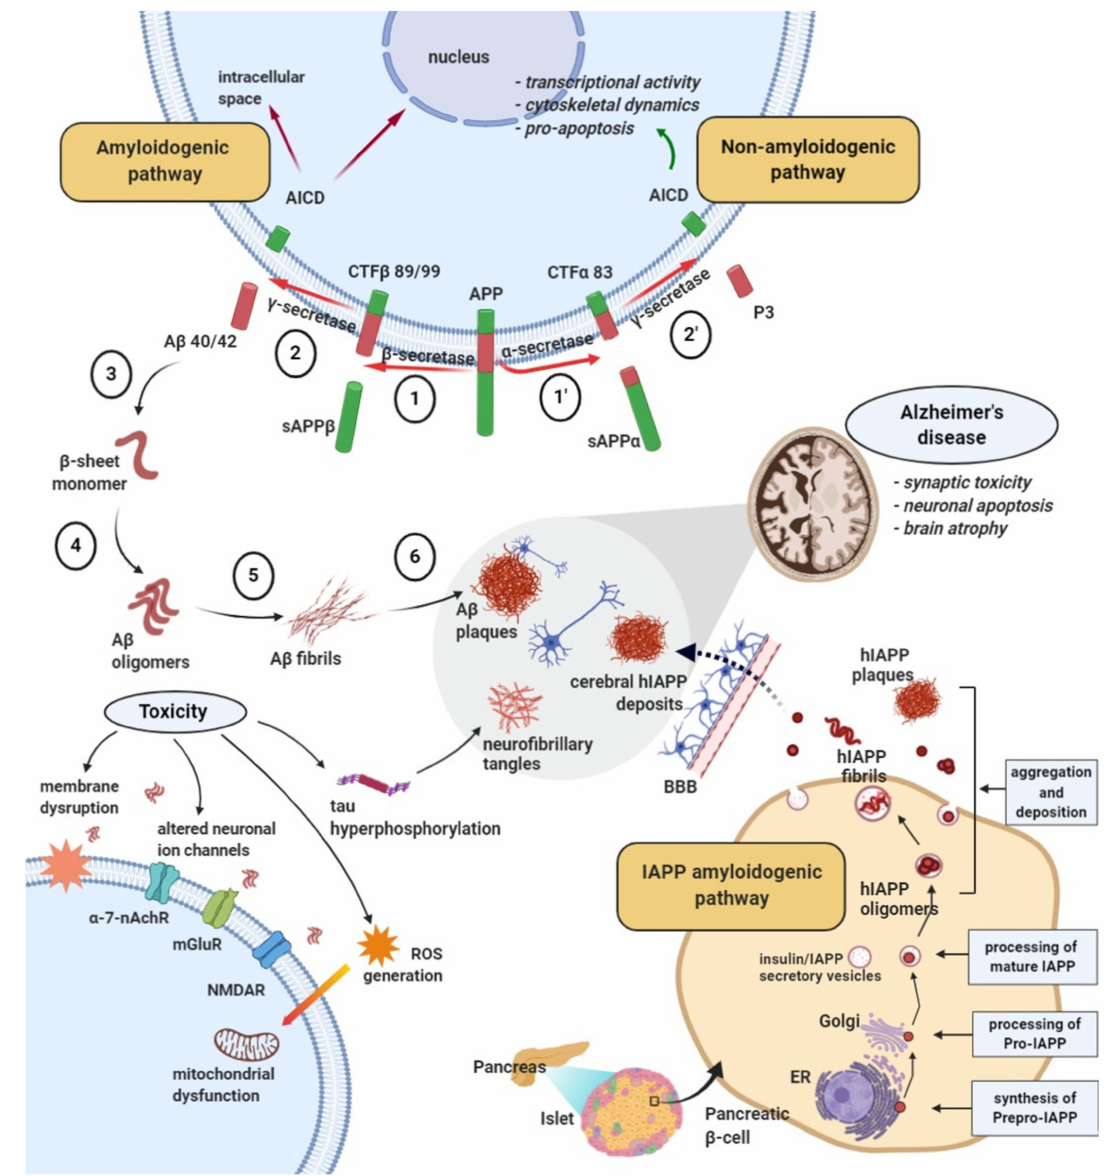
Figure 3. Amyloidogenic pathways of amyloid-beta peptide development in Alzheimer’s disease and islet amyloid polypeptide in diabetes. (1) Proteolytic cleavage of the transmembrane glycoprotein β -amyloid precursor protein (APP) by beta-secretase (amyloidogenic pathway) into the extracellular sAPP β and the membrane β -C-terminal membrane-bound (CTF- β ) 89 / 99 or (1 (cid:48) ) by alpha secretase resulting into extracellular sAPP α and membrane CTF- α 83 fragment (non-amyloidogenic pathway). (2) Further cleavage of the CTF- β fragments at multiple sites by γ -secretase, resulting in the formation of extracellular A β 40–42 monomers and intracellular APP intracellular domain (AICD) that can translocate to the nucleus (2 (cid:48) ) CTF- α cleavage by γ -secretase generating non-toxic extracellular P3 peptide and intracellular AICD. (3) A β conformational rearrangement from α -helical structure to β -sheet secondary structure monomers. (4) Assemblage of β -sheet A β monomers into soluble oligomers responsible for neuronal toxicity through mitochondrial dysfunction and membrane receptor binding. (5) Gradual aggregation of A β oligomers into insoluble amyloid fibrils and (6) deposits of amyloid senile plaques characteristic of AD. The initially 89 amino acid long islet amyloid polypeptide (IAPP) pre-pro peptides / along with the pro-insulin precursor / are synthesized in the endoplasmic reticulum of the pancreatic islet β -cells and then processed by enzymatic cleavage at both C-terminal and